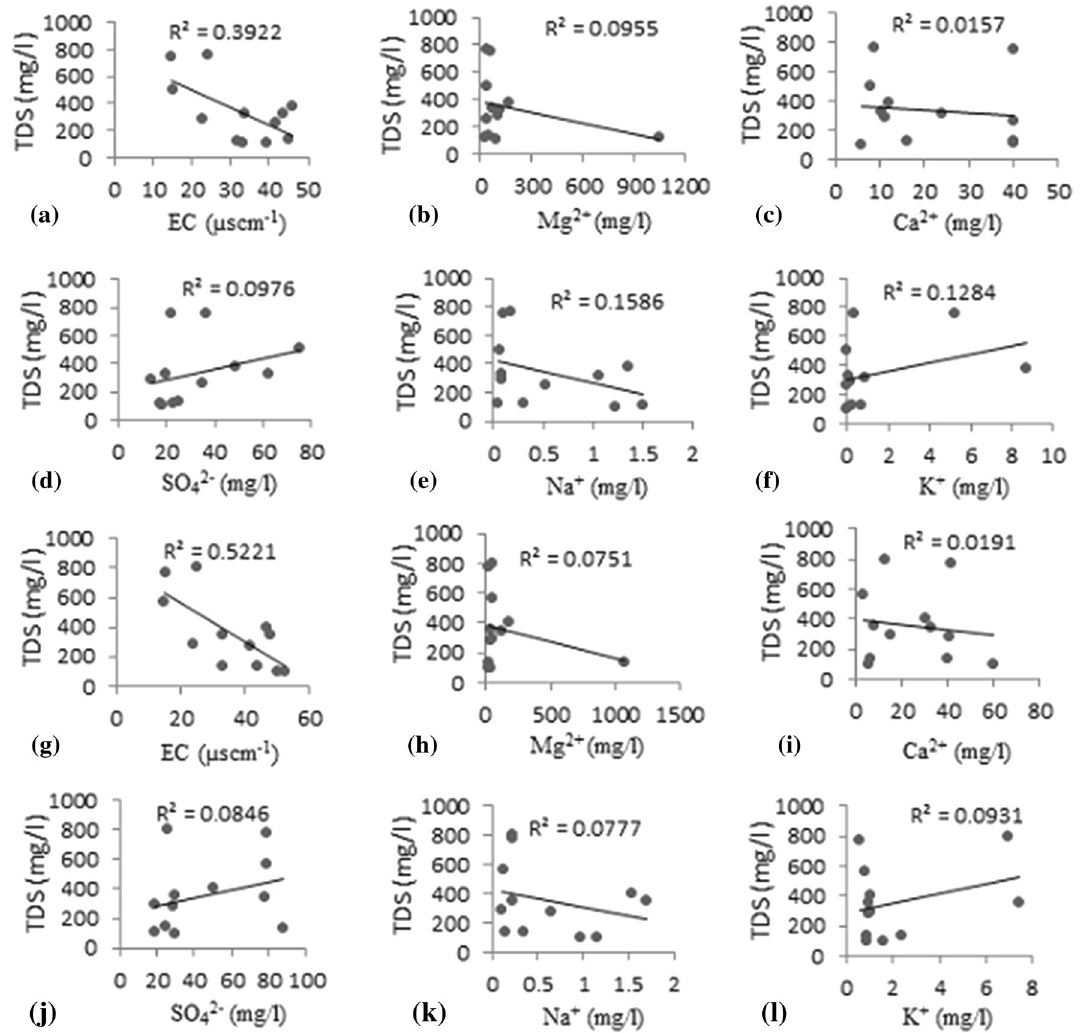
Fig. 16 Correlation between TDS and major